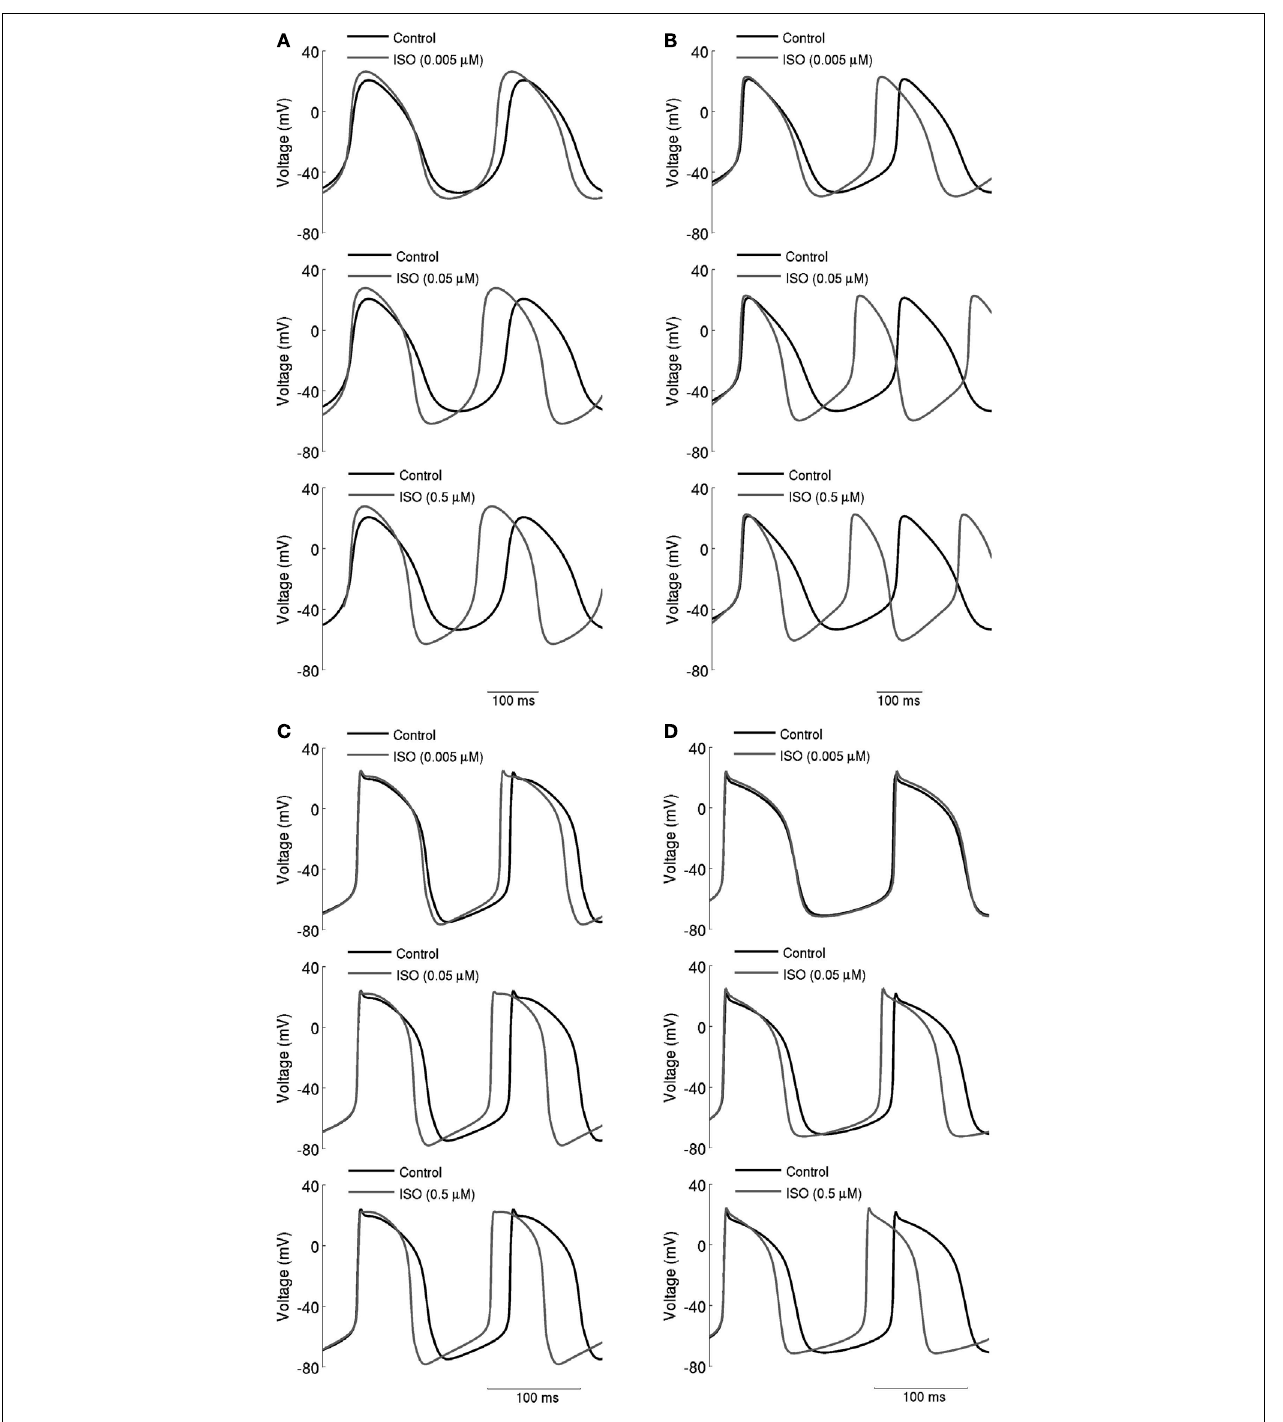
shown under control conditions and in the presence 0.005, 0.05, and 0.5 µ M ISO. Spontaneous firing rate was increased by ISO in a dose-dependent